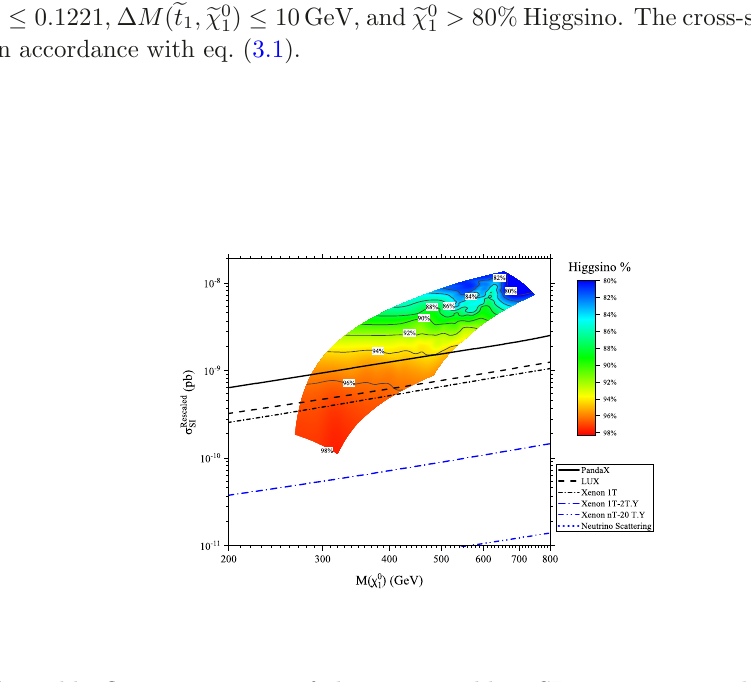
Figure 2 . Smoothly flowing contours of the Higgsino-like LSP percentage within the -SU(5) F D-brane inspired naturalness region. The LUX, PandaX-II, and XENON100 dark matter direct detection upper limits on spin-independent neutralino-nucleus cross-sections are sketched and la- beled. The region illustrated here satisfies the constraints M ( g ) 1 . 6 TeV, 124 m h 128 GeV, ≥ ≤ ≤ Ω h 2 0 . 1221, ∆ M ( t 1 , χ 0 ) 10 GeV, and χ 0 > 80% Higgsino. The cross-sections σ Rescaled are 1 1 SI ≤ ≤ rescaled in accordance with eq. e e